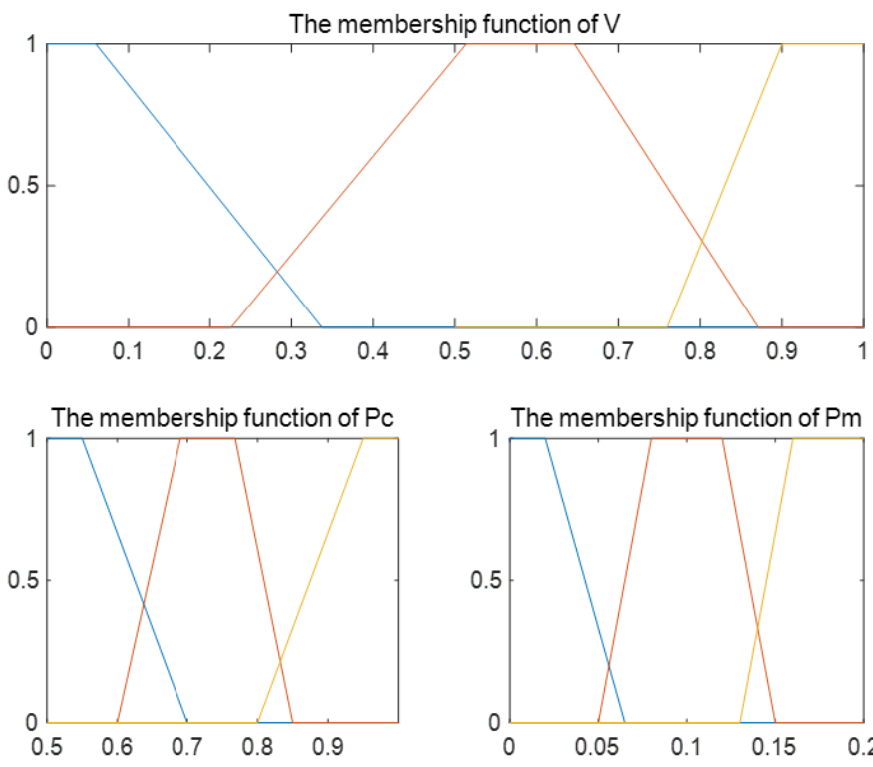
Figure 4. FAGA membership function